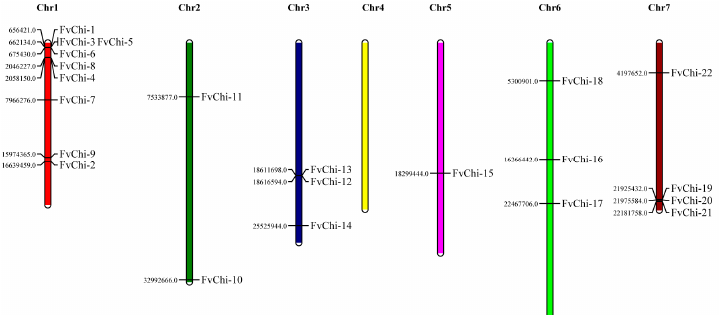
Figure 1. Chromosomal distribution of the FvChi genes. The numbers indicate where the genes start on the chromosomes. Based on their chromosomal order, the FvChi genes were given the names FvChi-1 to FvChi-23 .